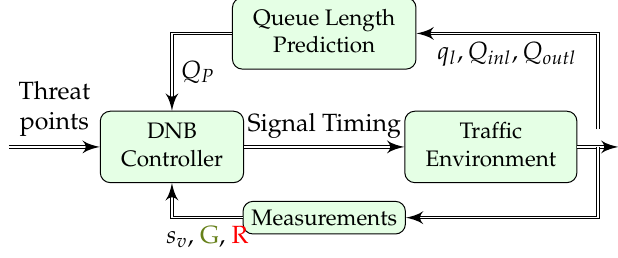
Figure 3. System block